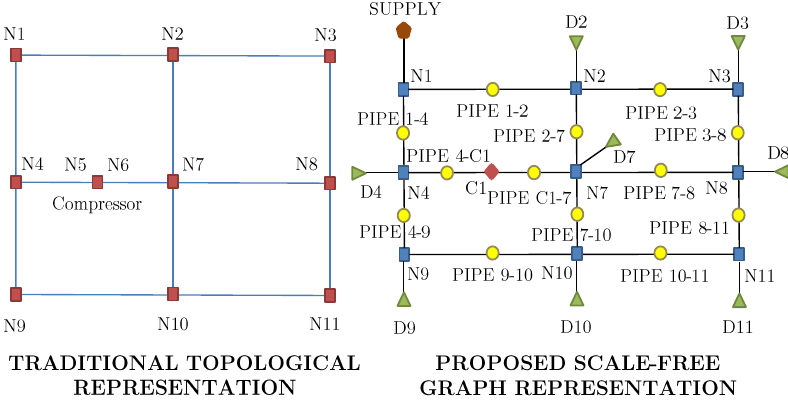
Figure 2. Proposed representation as a scale-free graph of a natural gas network.